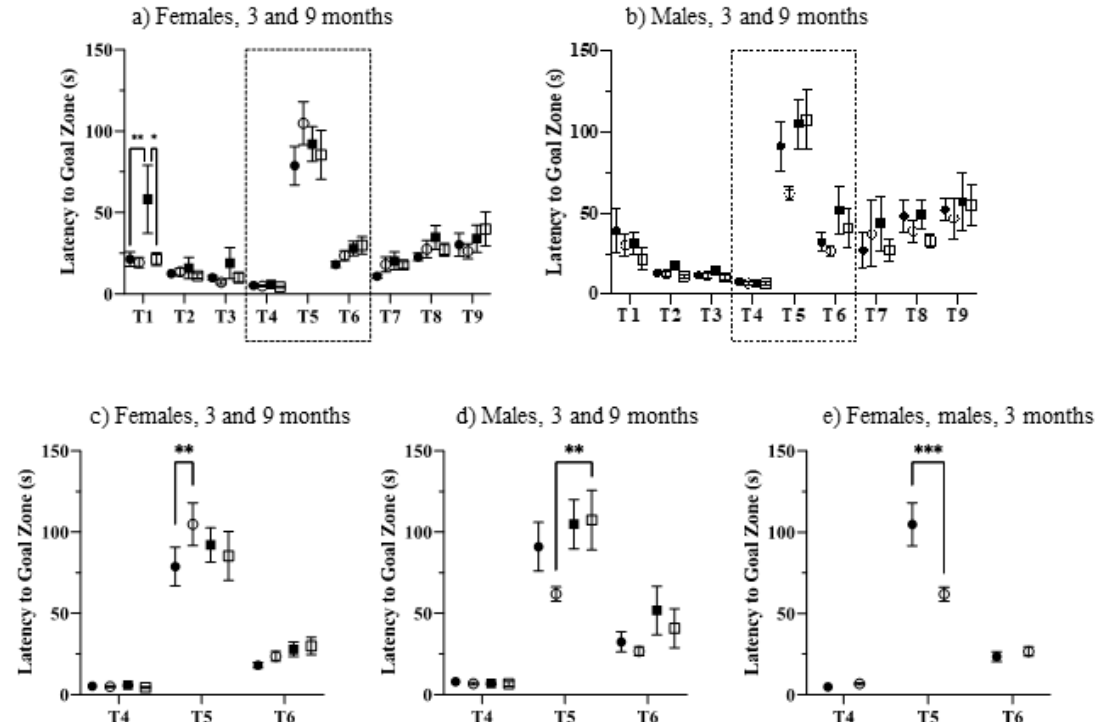
Figure 4. Puzzle box. ( a – d ), 3-month, control, filled circles; Dp10, open circles; 9-month control, filled squares; Dp10, open squares. ( c ) 3 month, Dp10 female, filled circles; Dp10 male, open circles. Dashed boxes in ( a , b ) indicated areas enlarged in ( c , d ). ( e ) 3-month Dp10, females, filled circle; 3-month Dp10, males, open circle. *, p ≤ 0.05; **, p ≤ 0.01; ***, p ≤ 0.001.